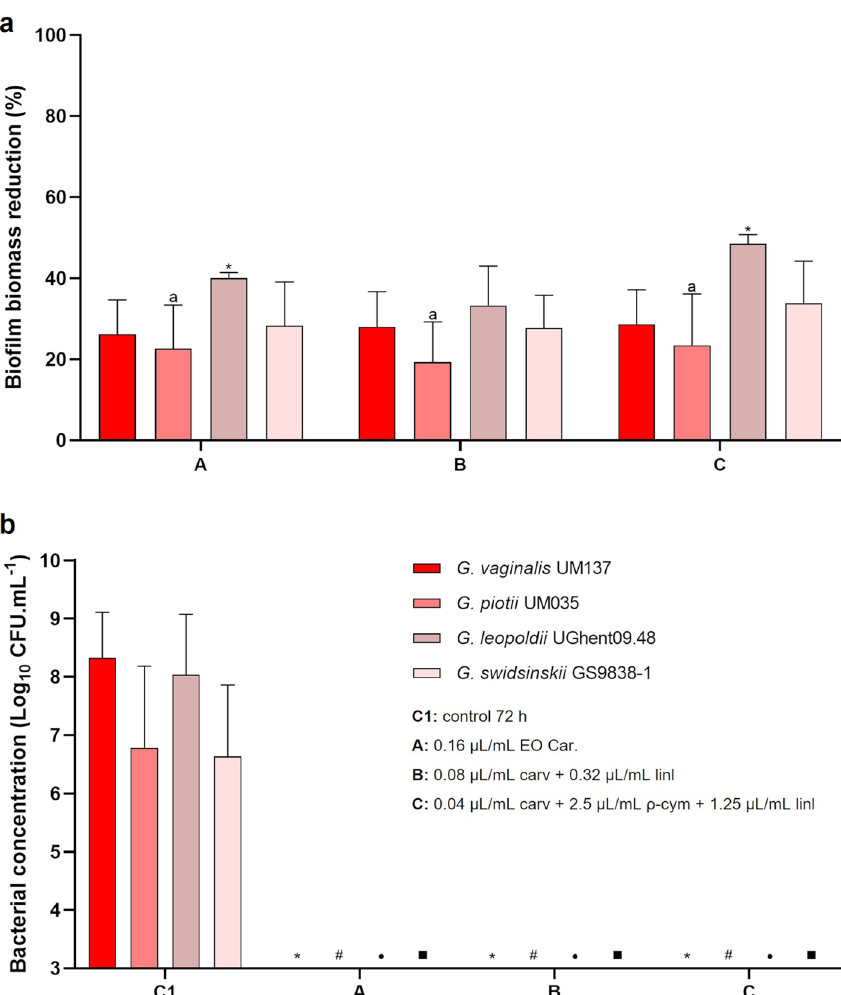
Figure 3. Activity of EO Car. and two combinations among compounds on a 48 h biofilm of G. vaginalis UM137, G. piotii UM035, G. leopoldii UGent 09.48 and G. swidsinskii GS 9838–1. a : Effect on biofilm biomass reduction. Results are presented in percentage (%) of biofilm biomass reduction. Error bars represent s.e.m. Statistical differences were found for all the conditions when compared with the 72 h-biofilm control, except for G. leopoldii where no differences were found ( a ) (t-test, n = 4). Statistical differences were found in G. leopoldii, between conditions A and C (asterisk symbol) (t-test, n = 4). ( b ) Effect on biofilm cells culturability. Results are represented as mean of Log (CFU.mL −1 ) with a limit of detection of Log = 3. Error bars represent s.d. Statistical analysis was performed using t-test (n = 4). Differences are represented when p < 0.05, when compared with control 72 h of G. vaginalis UM137 (asterisk symbol), G. piotii UM035 (hash symbol), G. leopoldii UGent 09.48 (bullet symbol) and G. swidsinskii GS 9838-1 (filled square